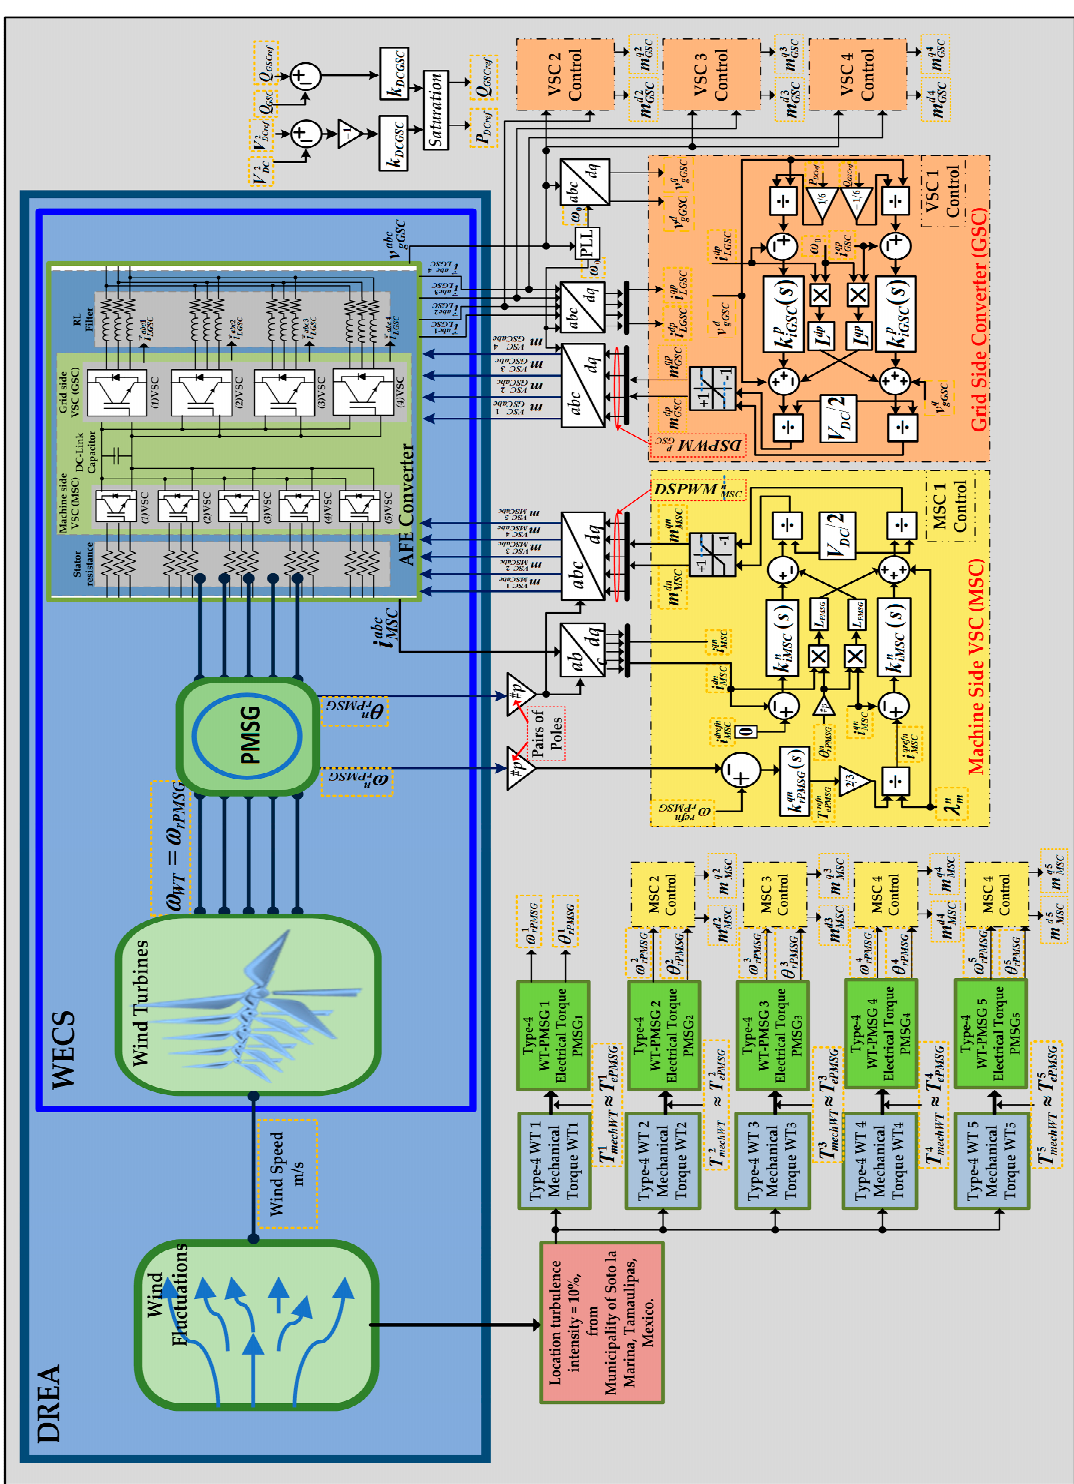
Figure 6. Distributed renewables energy access (DREA) through a wind energy conversion system (WECS) based on the type-4 wind turbine (WT) control.